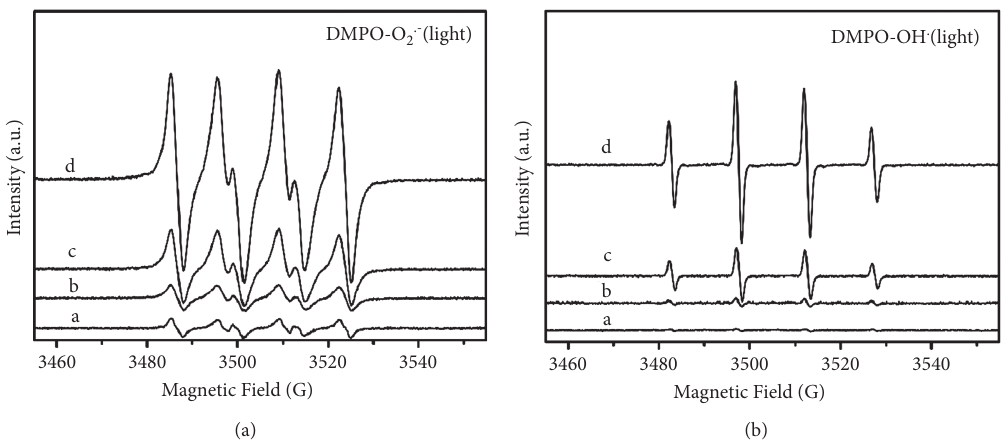
Figure 7: ESR signals of (a) DMPO-O 2- and (b) DMPO-OH . for (A)AgSb